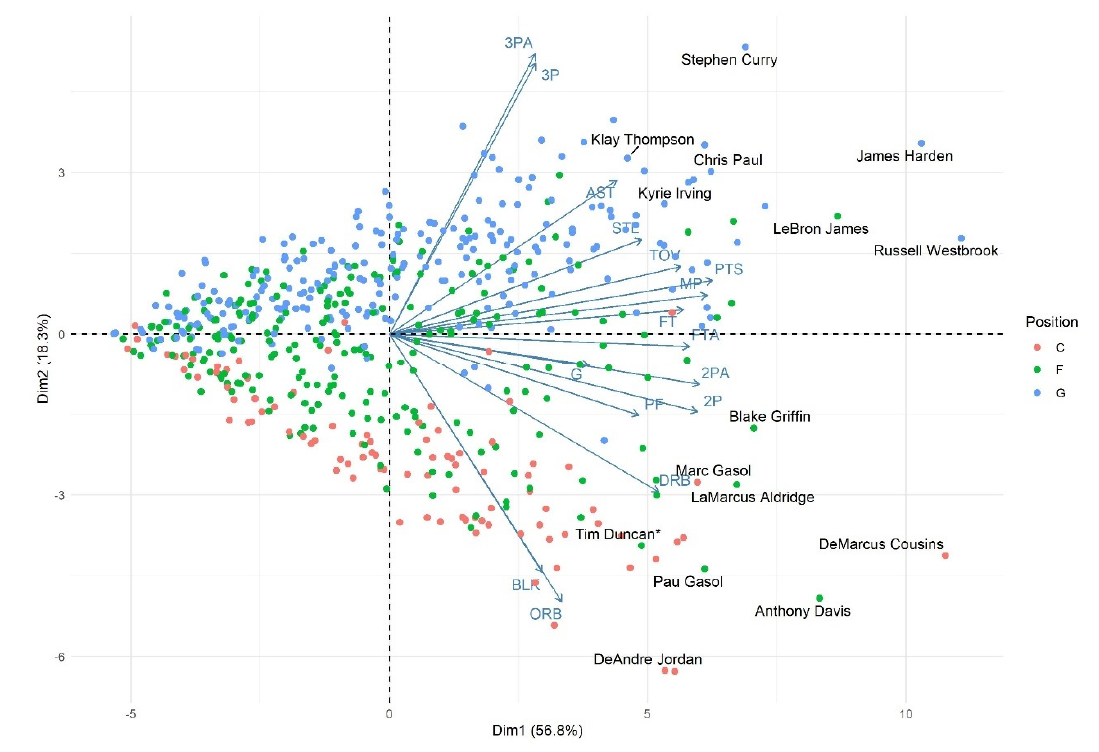
Figure A2. Principal Component Analysis of active players in the 2014–15 NBA Season.